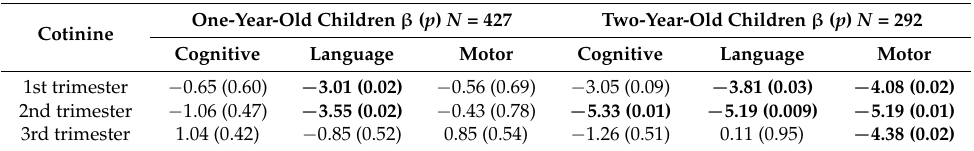
Table 3. ETS exposure during pregnancy based on the cotinine level in saliva and child psychomotor development at one and two years of age. The multivariate linear regression model. Cotinine